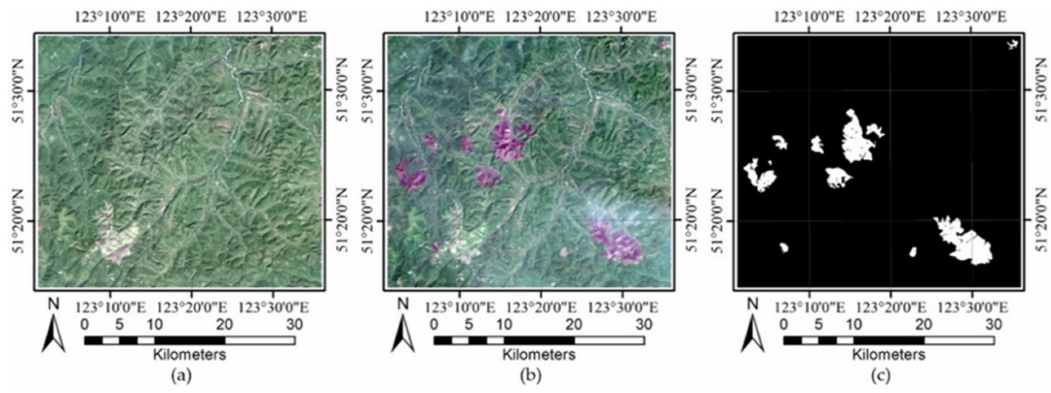
Figure 3. ( a ) Image of 2006, ( b ) image of 2011, and ( c ) reference map.